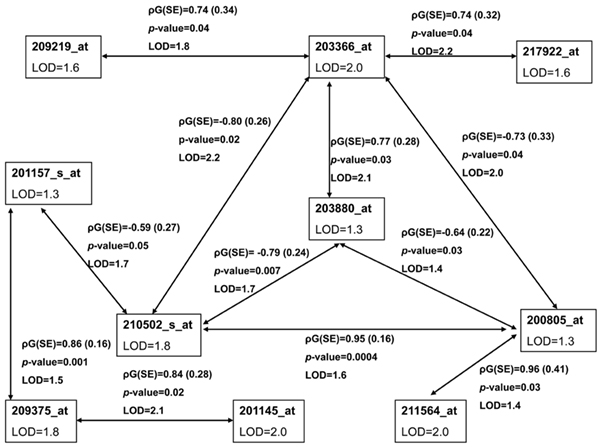
Chromosome 13 co-localized gene transcriptsunivariate and bivariate analyses results (n = 12 transcripts). See legend to Figure 1 for explanation of symbols.